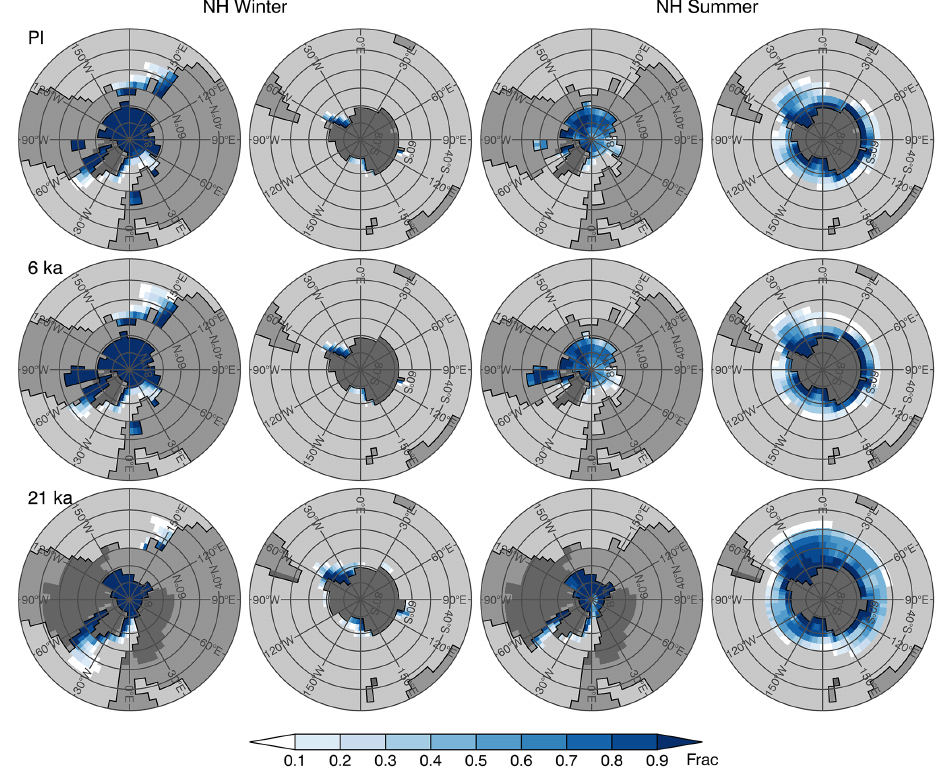
Figure 11. Simulated sea ice fraction for PI and 6 and 21ka. Left two columns: February–March. Right two columns: August–September. Medium gray is continental land mass and dark gray is continental ice